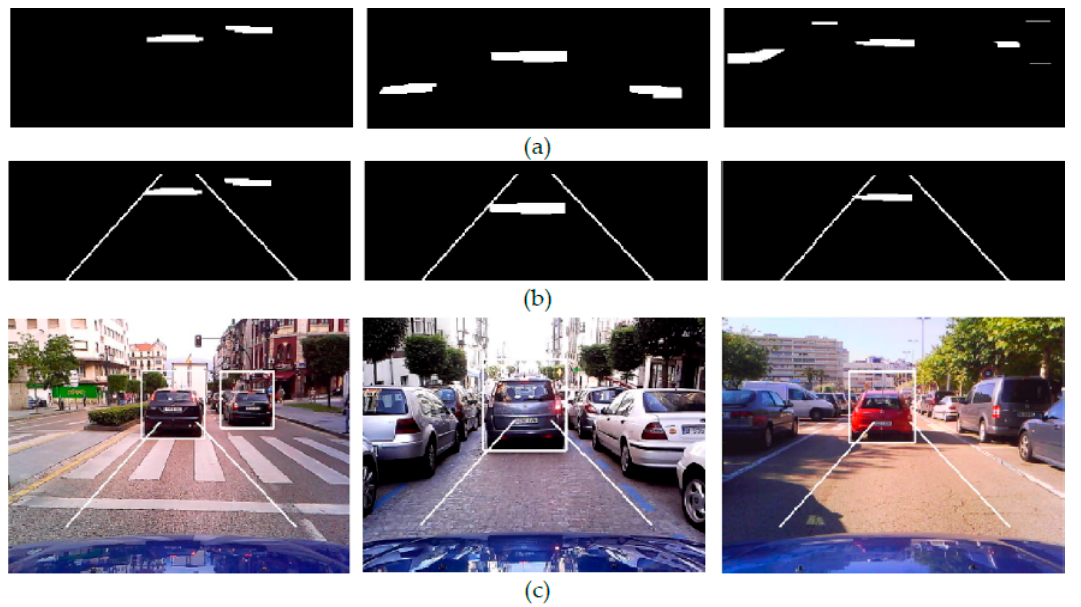
Figure 5. ( a ) Binary mask M ( x , y ) of Figure 2 after horizontal clusters extraction ( b ) M ( x , y ) after morphological thresholding and ROI establishment; and ( c ) vehicle hypotheses including those out of the ROI.